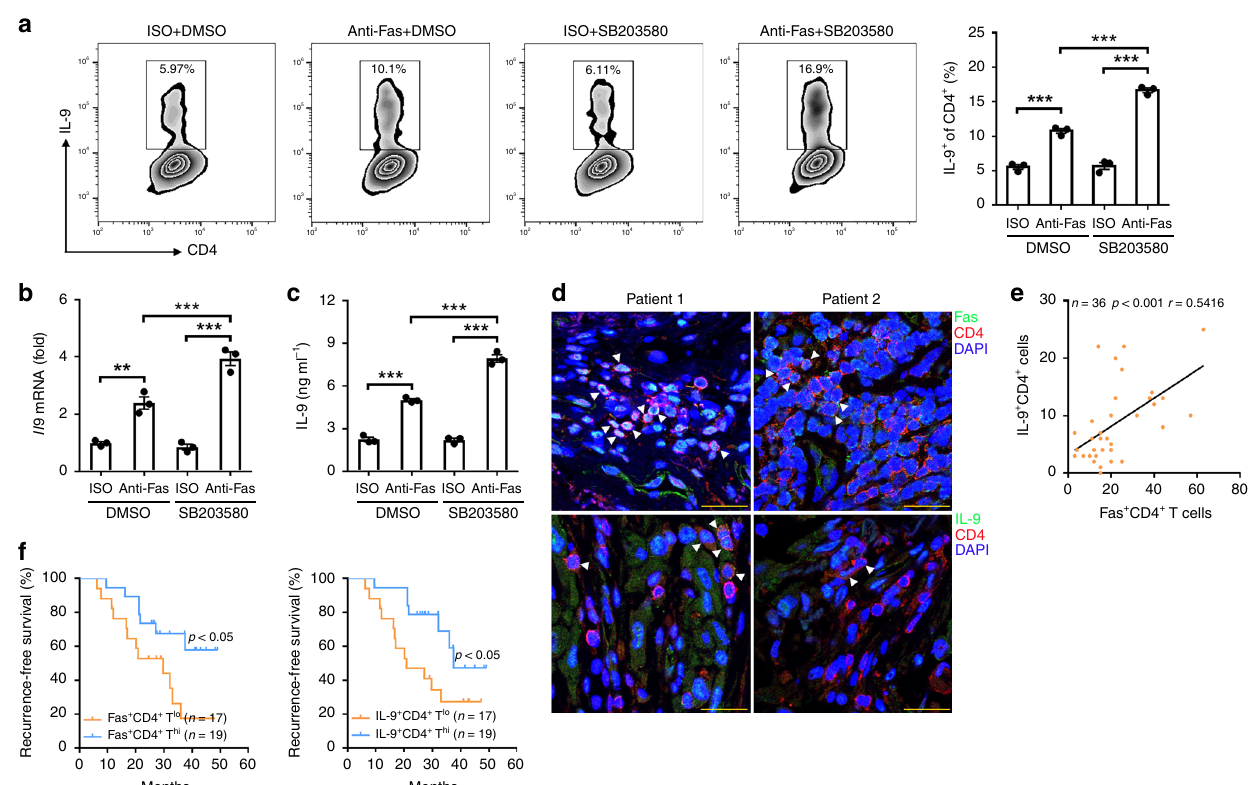
Fig. 8 Fas-related T helper type 9 (T H 9) cells indicate a good prognosis. a – c Flow cytometric analysis of the frequency of IL-9 + (interleukin-9 + ) cells among CD4 + T cells (left) and the corresponding statistical analysis (right) ( a ), real-time PCR analysis of Il9 messenger RNA (mRNA) expression in T H 9 cells ( b ), and enzyme-linked immunosorbent assay (ELISA) measurement of the IL-9 level ( c ) in T H 9 cells after the stimulation of human naive CD4 + CD45RA + CD45RO − T cells with 10 μ g ml − 1 ISO or antibodies against human Fas (anti-Fas) with or without the p38 inhibitor SB203580 (0.4 μ M) under T H 9-skewing conditions for 4 days ( n = 3). d Representative immuno fl uorescence staining of Fas + CD4 + and IL-9 + CD4 + T cells in tumor tissues from non-small-cell lung carcinoma (NSCLC) patients. Arrows indicate Fas + CD4 + or IL-9 + CD4 + T cells. e Pearson ’ s correlation between Fas + CD4 + T cells and IL-9 + CD4 + T cells in tumor tissues from NSCLC patients. f The relationship between the recurrence-free survival rate of NSCLC patients and the corresponding Fas + CD4 + or IL-9 + CD4 + T cell numbers in tumor tissues. Scale bar = 25 μ m. ** P <0.01 and *** P <0.001 (unpaired Student ’ s t test: a (right) – c , Spearman ’ s rank-order correlation test: e ; or log-rank test: f ). Representative results from three independent experiments are shown (mean and